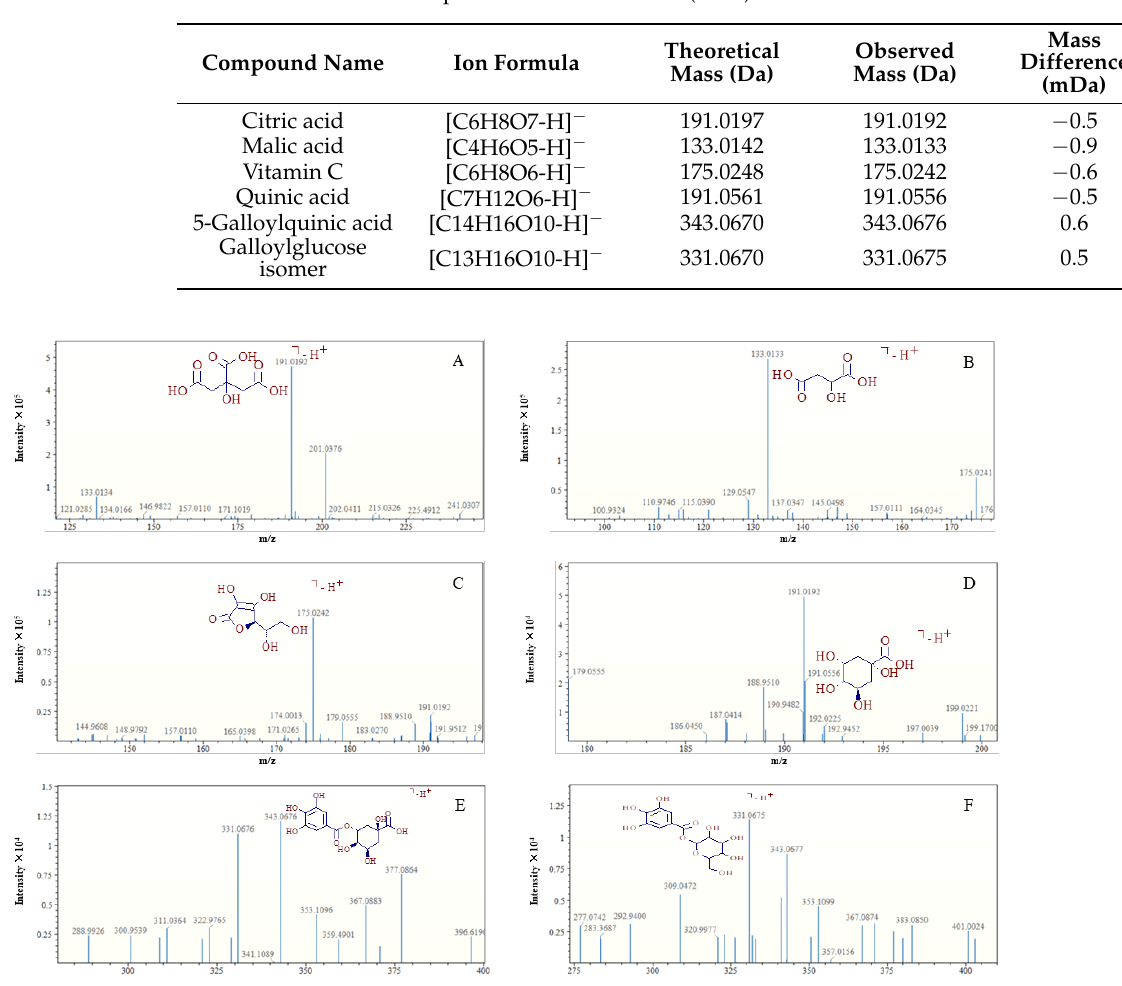
Table 1. Ion formula, theoretical mass, and observed mass of low molecular metabolites in mango. Figure 1. Microstructure of mango tissue slice, ×100. The mass difference was represented as millidalton (mDa).